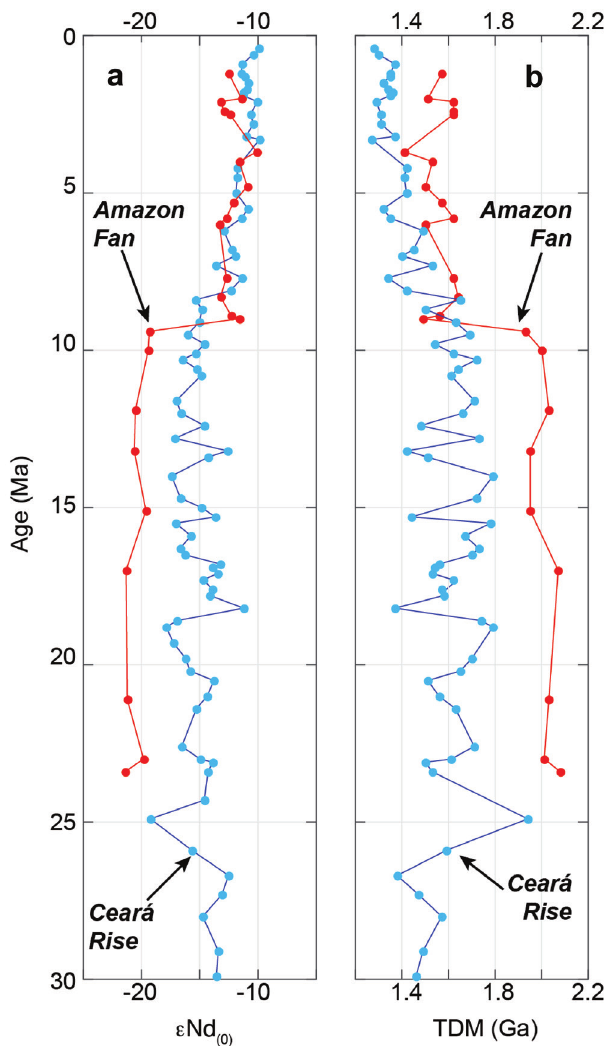
Fig. 2. Summary of terrigenous signals from drilling cores near the mouth of the Amazon River. Sediment dating of cores in the Amazon Fan (red; Hoorn et al. , 2017) and Ce- ará Rise (blue; van Soelen et al ., 2017). a. Ratios of stable Neodymium isotopes expressed in epsilon notation: